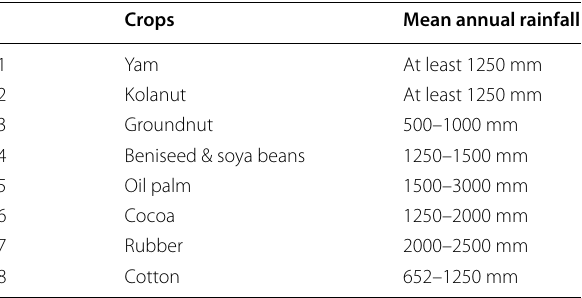
Table 12 Rainfall requirement for some selected crops